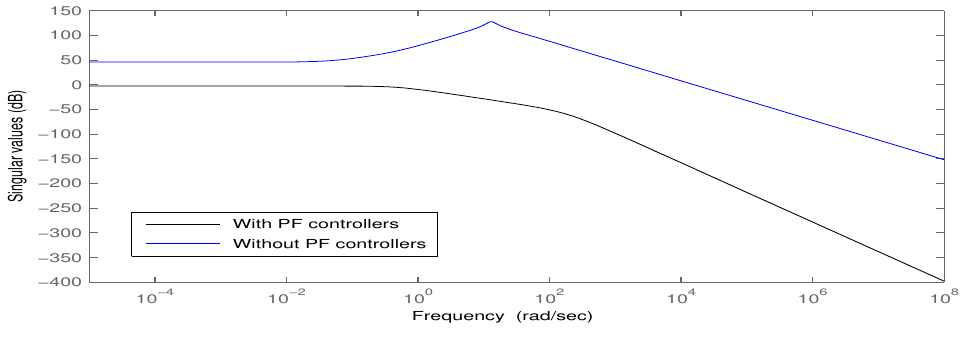
Figure 11. Singular values plot of frequency control loop ( ∆ F ∗ → ∆ F ).